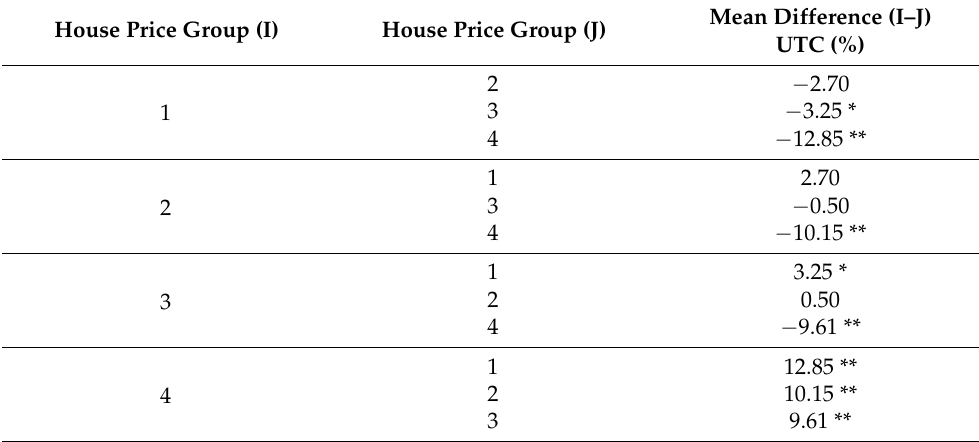
Table 5. Analysis of variance